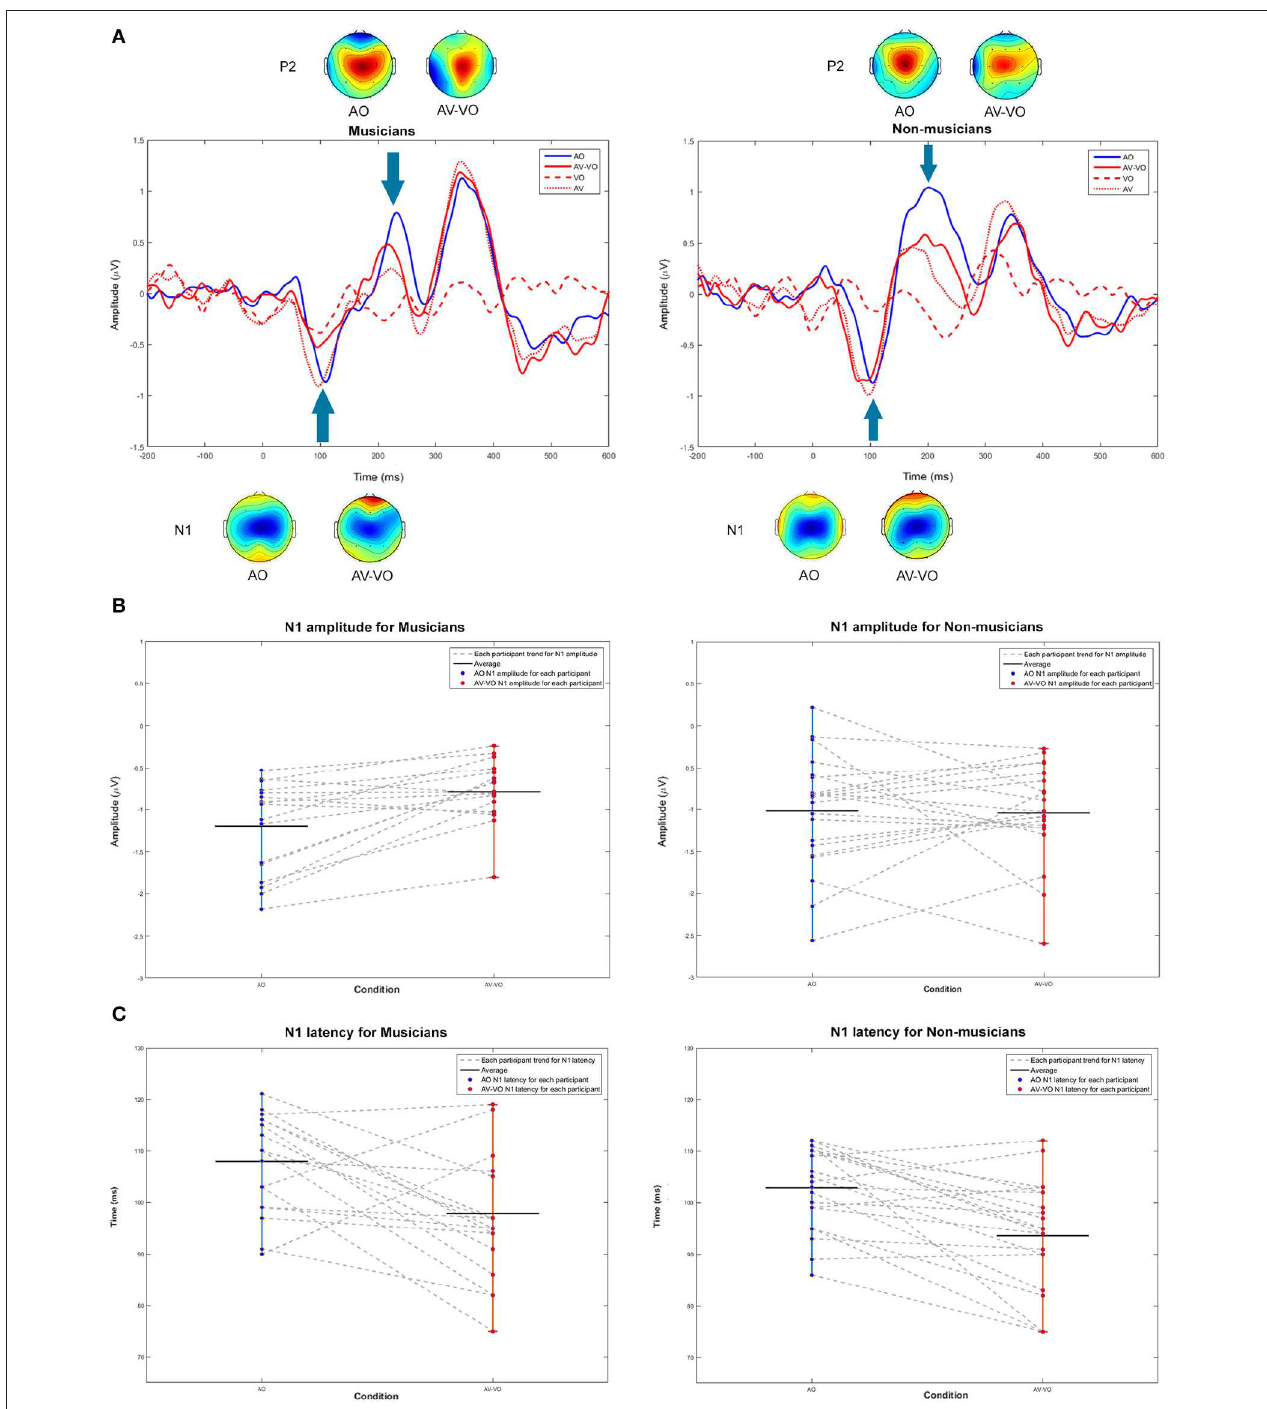
FIGURE 2 | (A) Grand averaged waveforms at Cz and topographical maps in N1 and P2 windows for audio only (AO) in blue, video only (VO) in red dashed-line, audiovisual (AV) in red dotted-line, and audiovisual minus video only (AV − VO) in red line. (B,C) Shift functions at N1 amplitudes and latencies for musicians and non-musicians. Each gray dashed-line connect each participants AO and AV − VO data points.